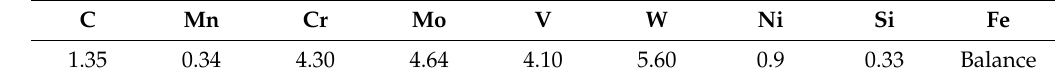
Figure 2. ( a ) Crack at the fifth layer of the sample; ( b , c ) show geometry, boundary conditions, and position of the thermocouples (TCs); in ( c ) both the laser path for preheating and deposition stages; ( d ) global view of the setup after deposit. Table 1. Chemical composition of high speed steel (HSS) M4 (wt.%).